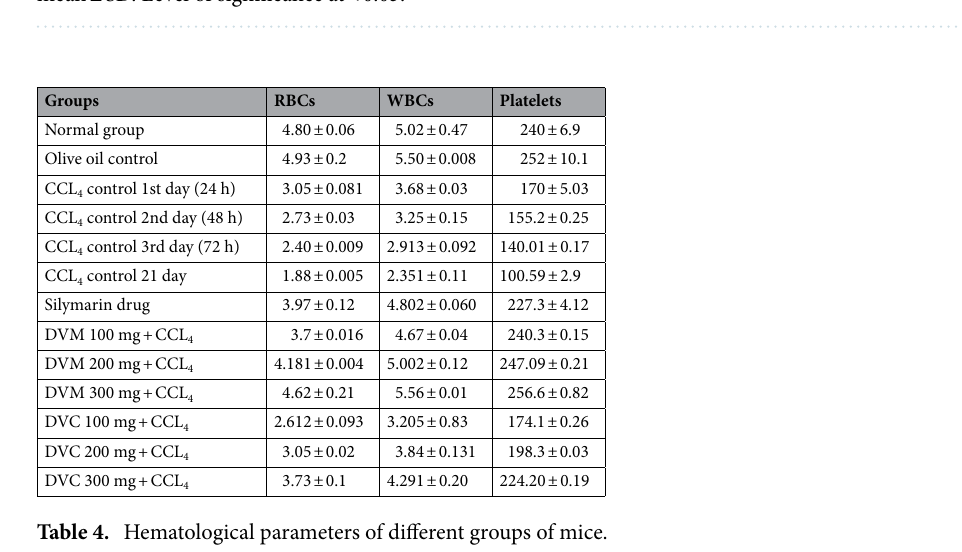
Table 3. Estimation of liver enzymes from mice blood serum. Results are taken in a triplicate way with mean ± SD. Level of significance at < 0.05.